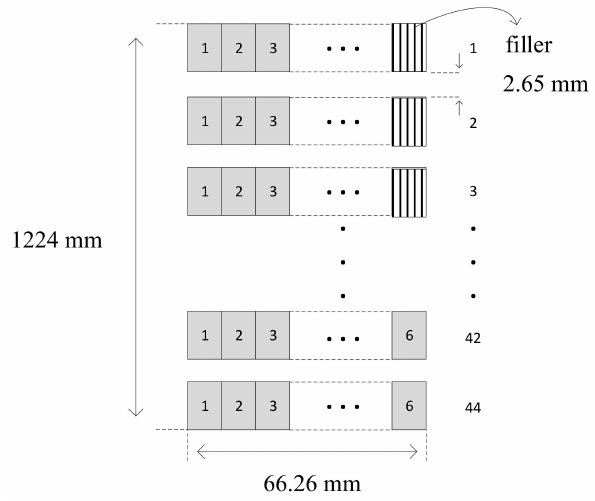
Figure 4. The arrangement of disk for LV